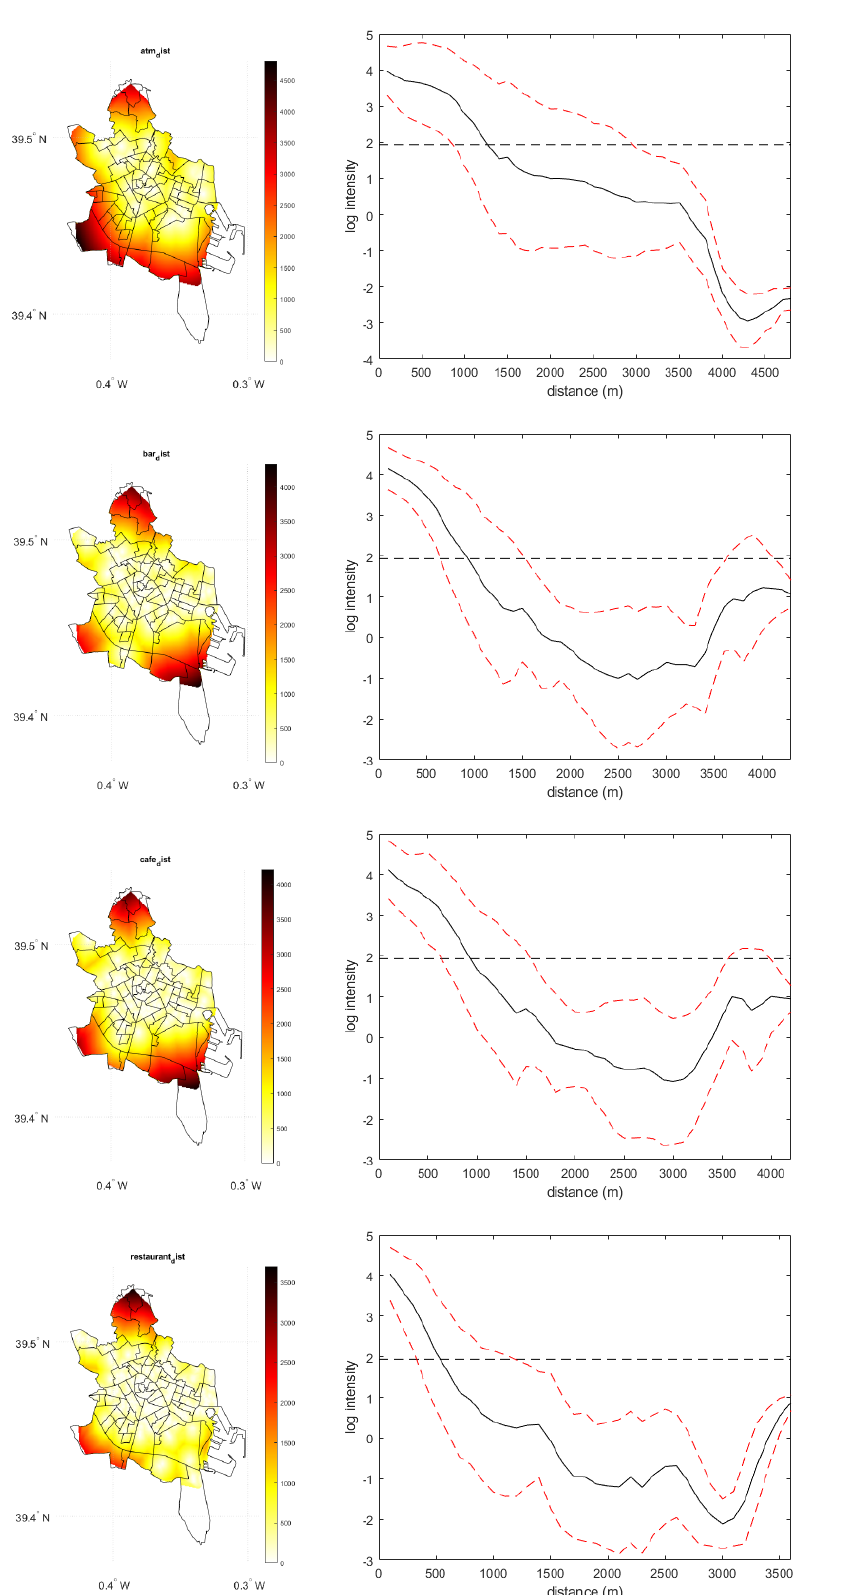
Figure 15. Maps of fixed effects and empirical relationship between distance-based fixed effects (atms, bars, cafes and restaurants) and the log spatial